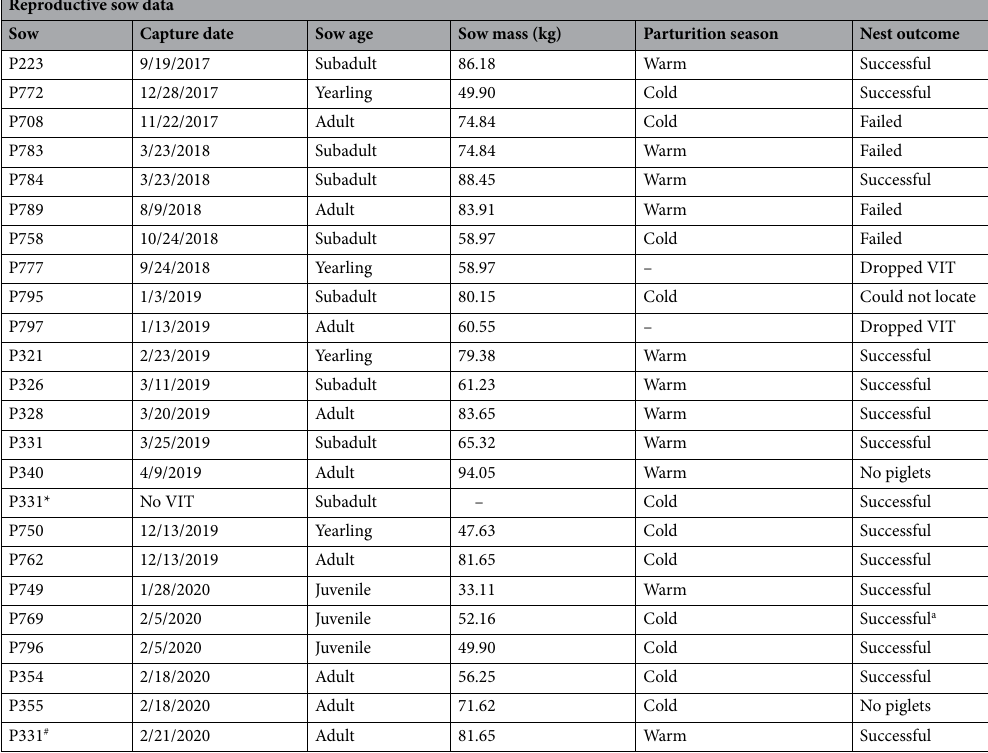
Table 1. Data for all wild pig ( Sus scrofa ) sows captured for neonate survival study, n = 24 and number of VIT deployed, n = 23 at the Savannah River Site, Aiken, Allendale, and Barnwell counties, SC, USA from 2017 to 2020. Nest outcome: successful, neonates tagged and sow returned to nest; failed, neonates tagged and sow abandoned nest; dropped VIT, VIT failure and could not determine parturition event; could not locate, sow gave birth but nest was not located. Note: sow P331 gave birth three times during the study. Sow age class was determined in the field by molar eruption patterns 47,48 . Age class categories were: Juveniles (< 1 year);